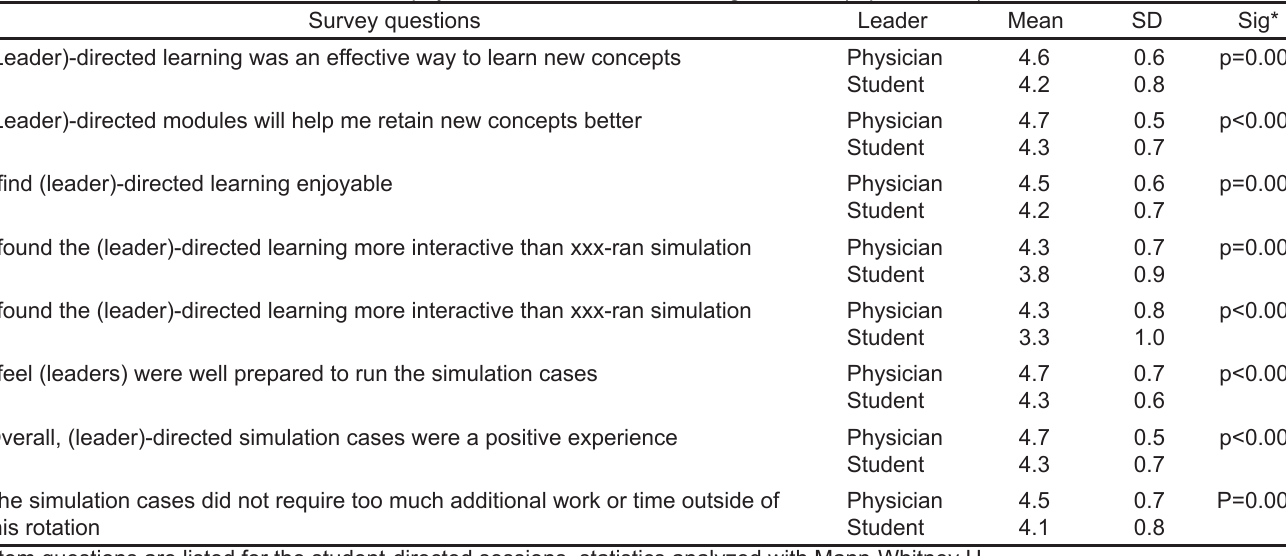
*Stem questions are listed for the student-directed sessions, statistics analyzed with Mann-Whitney U. SD, standard